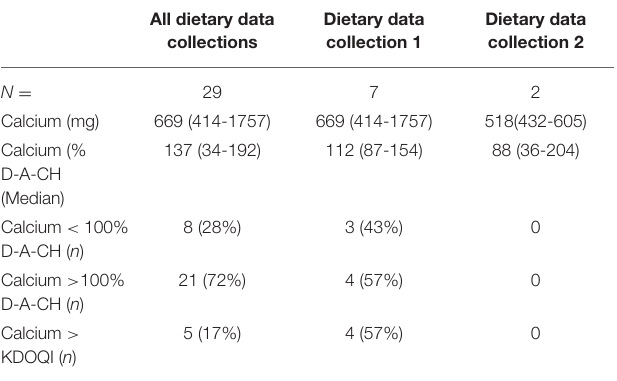
TABLE 3 | Calcium-Intake in patients taking calcium-containing phosphate binders. All dietary data collections